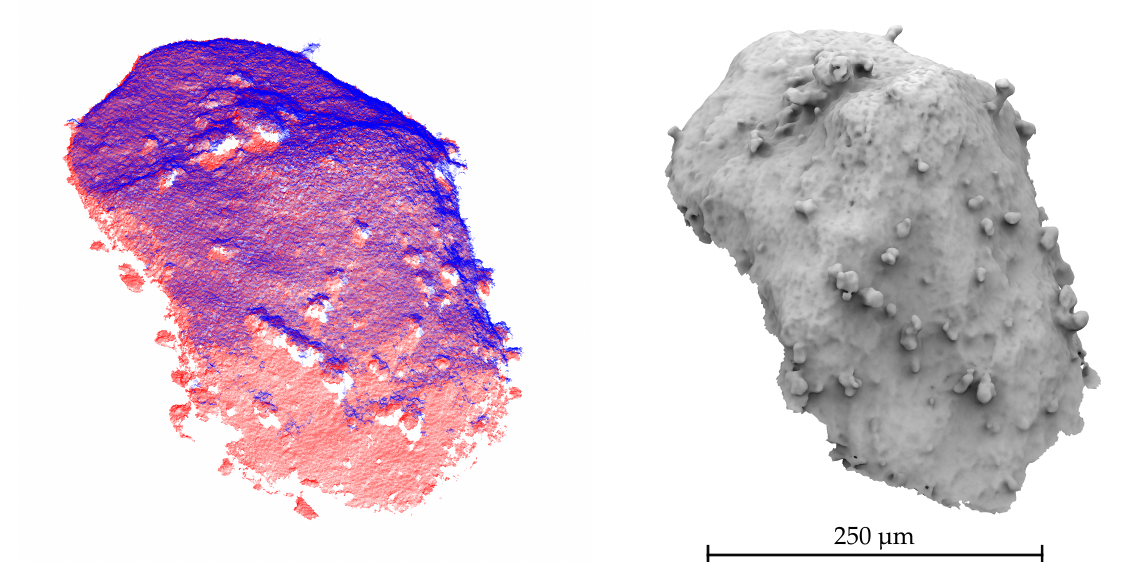
Figure 17. ( left ) Aligned dense point clouds, triangulated from the views ( − 15 ◦ / − 10 ◦ ) (red) and (20 ◦ /25 ◦ ) (blue). ( right ) Poisson surface reconstruction created from the merged point